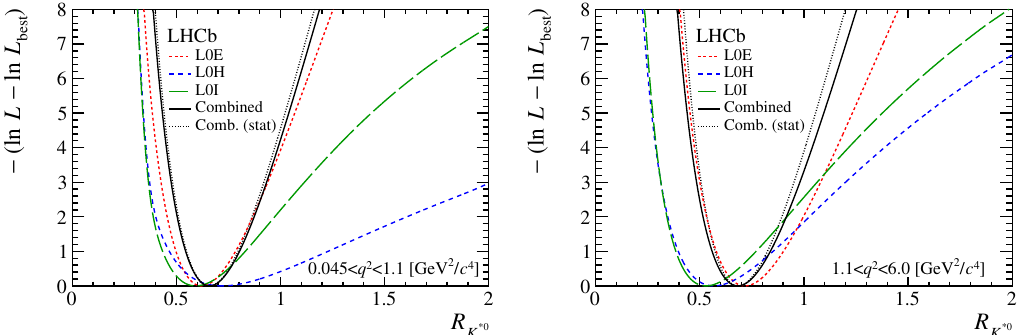
delta log-likelihood for the three trigger categories separately K (cid:3) 0